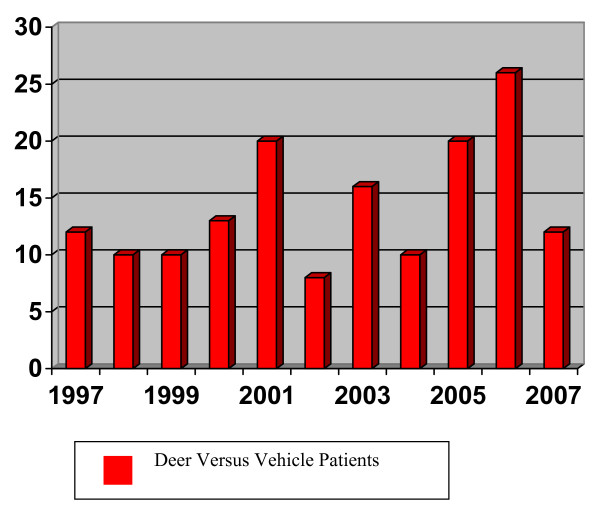
Deer versus Vehicle Trauma Patients by Year-Mayo Clinic.